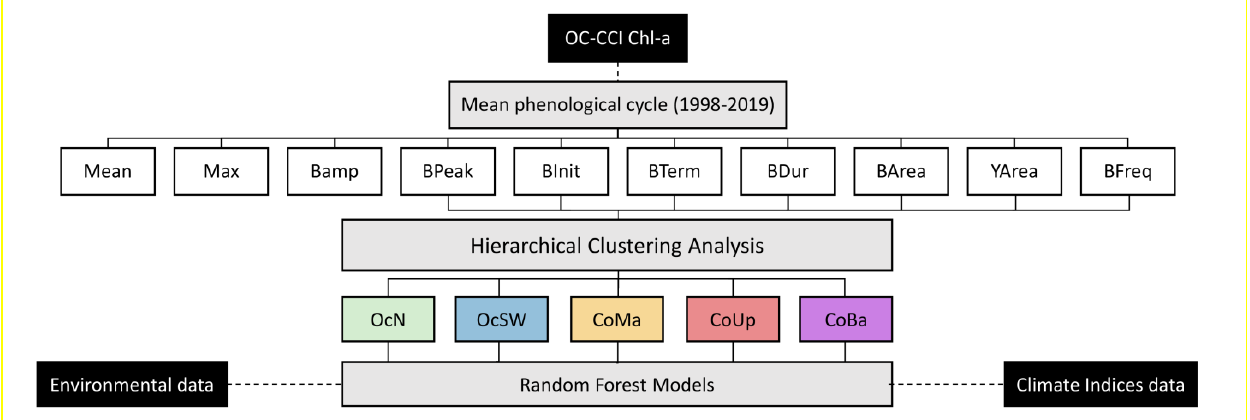
Figure 3. Flowchart representing the workflow presented in this work. See Table 1 for more information on the phenological metrics.